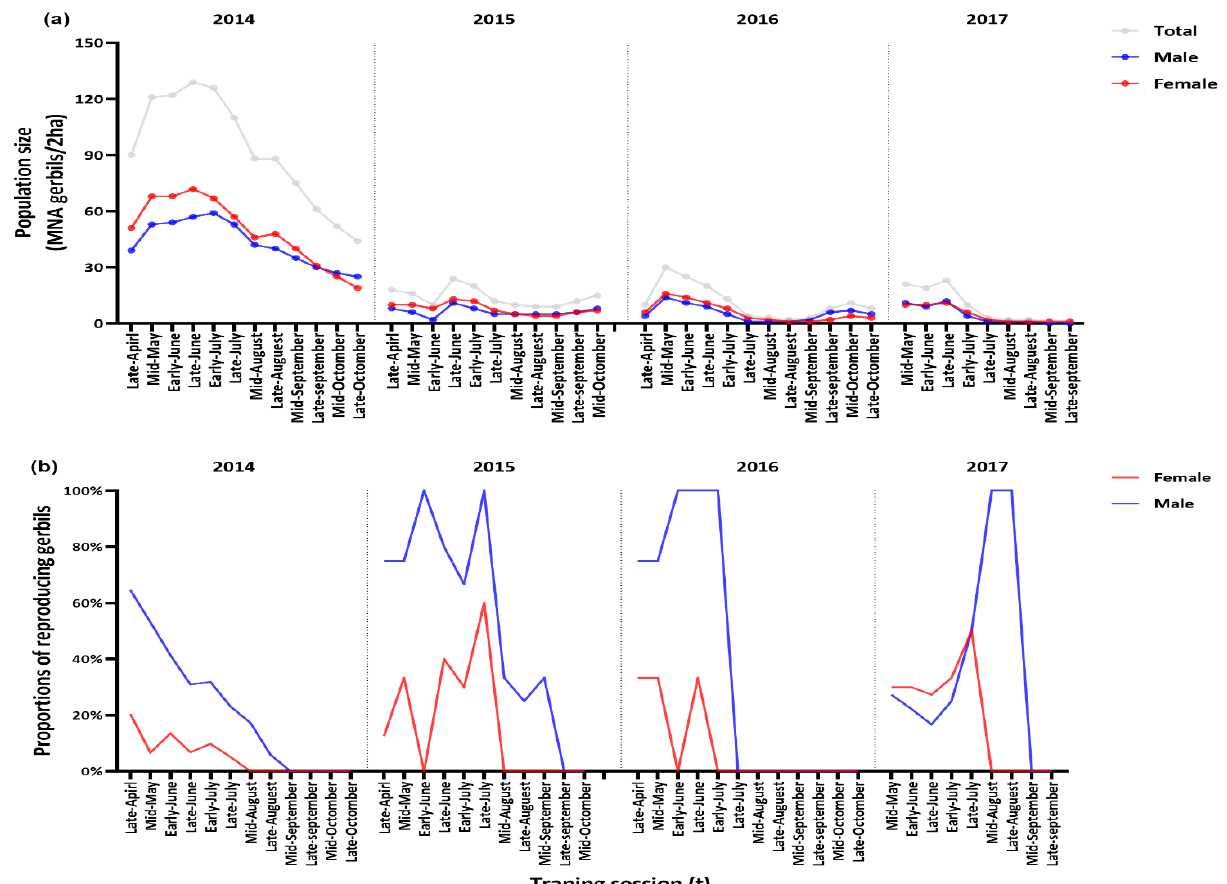
Figure 2. ( a ) Half-monthly minimum number of alive Mongolian gerbils ( Merionus unguiculatus ) (MNA) and ( b ) half-monthly proportion of reproductively active males (PRM) in the total number of captured males, and proportion of reproductively active females (PRF) in the total number of captured females in Houhatai, Inner Mongolia, China from April 2014 to September 2017.